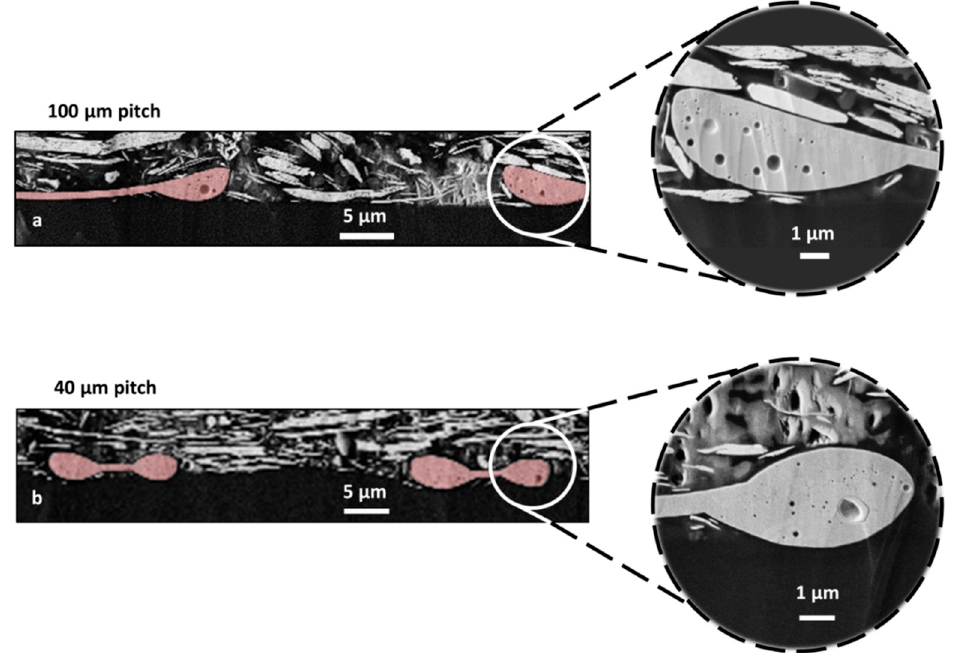
Figure 3. 3D profilometry mapping of a Ni linear array formed by directed dewetting with a spacing of 100 μ m. “Negative” and “Positive” relate to the surface of the original Ni film. Of the accounted volume, an 11.5% excess positive volume remains unaccounted for after the dewetting process. This is attributed to shadowing effects from the measurement and the shape of the features.